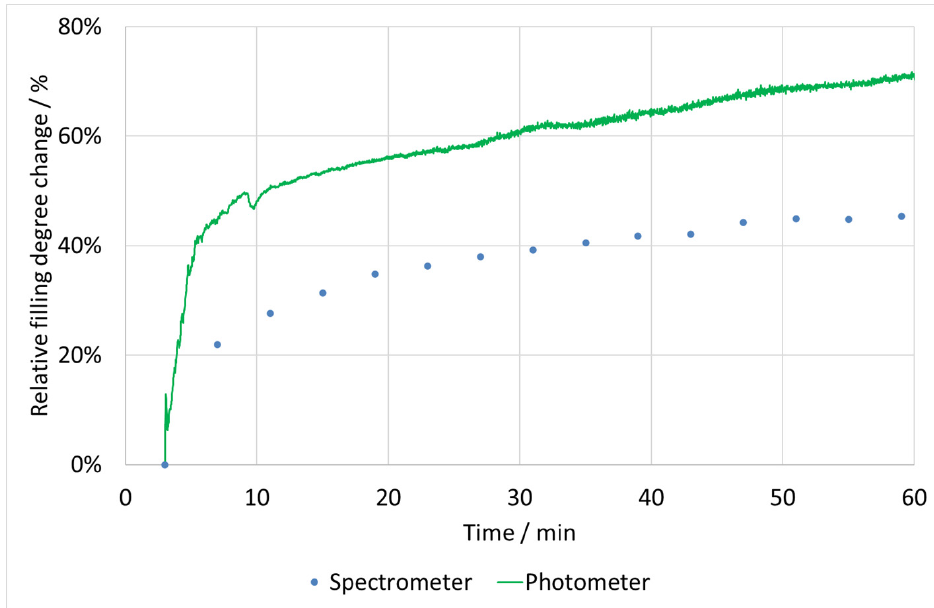
Figure 6. Results of the spectrometric and photometric measurements of the relative filling degree change of one droplet. The inner phase contained 49% ammonium nitrate, the outer phase, besides polyvinyl alcohol, 10% ammonium chloride.